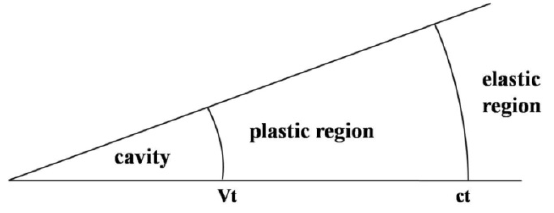
Figure 2. Soil response regions.